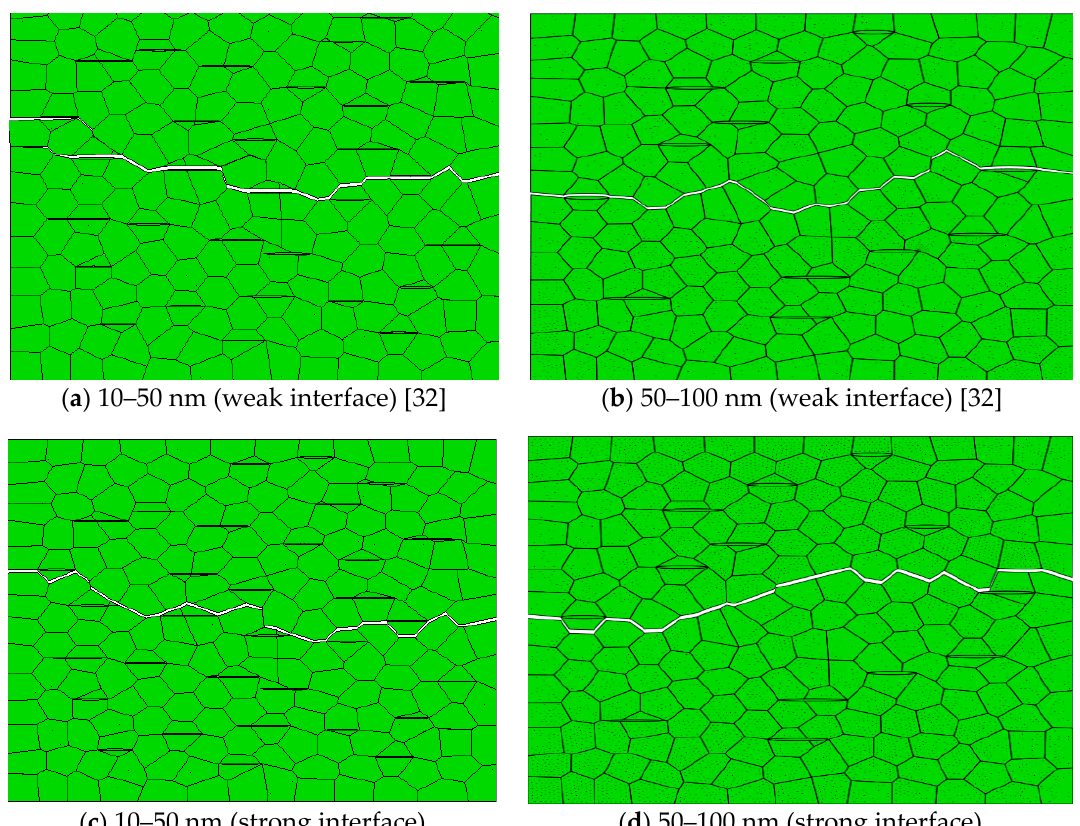
Figure 2. The simulation results of crack propagation paths with different short diameters when the long diameter of graphene is 800–1200 nm. Table 3. The calculation results of microscopic models with different short diameters when the long diameter of graphene is 800–1200 nm. The Short Diameter of Graphene